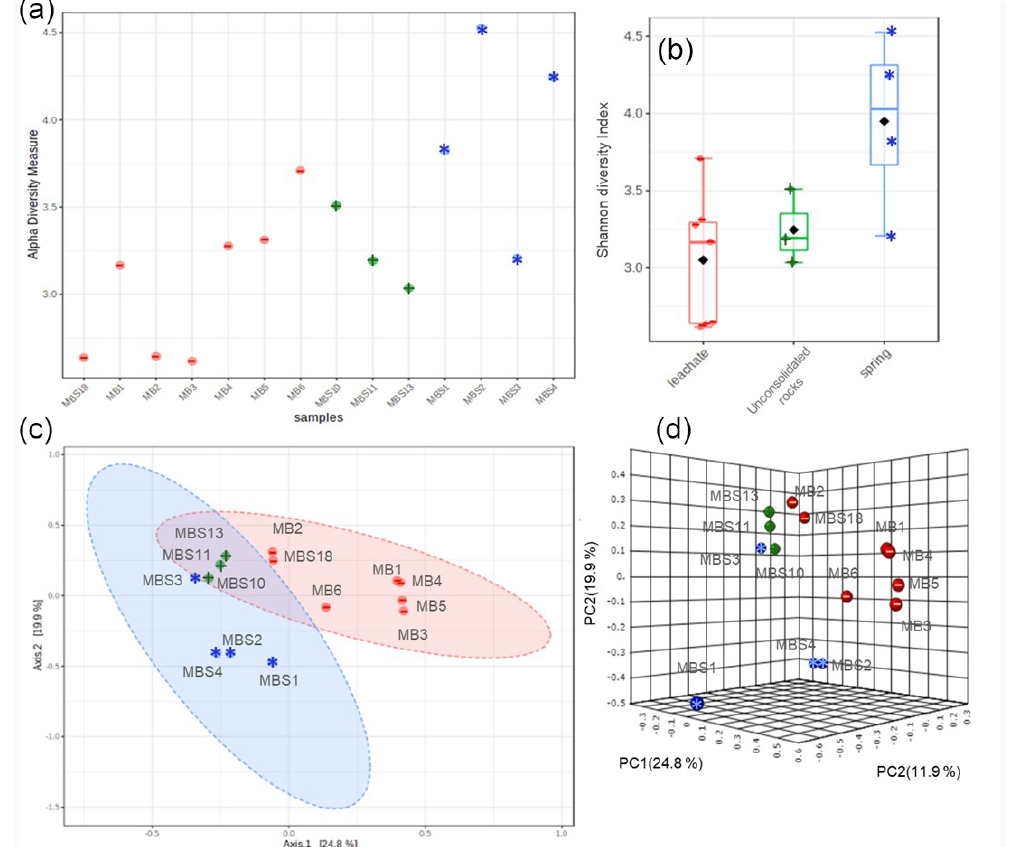
Figure 4. Alpha and beta diversity. Shannon diversity index (a) and box plots (b) depict that the spring water samples have the highest alpha diversity. The PCoA 2D (c) and 3D (d) graphs indicated the unconsolidated rocks ( + ) microbial communities share similarity with both the spring water ( ∗ ) and mine leachate (–) samples